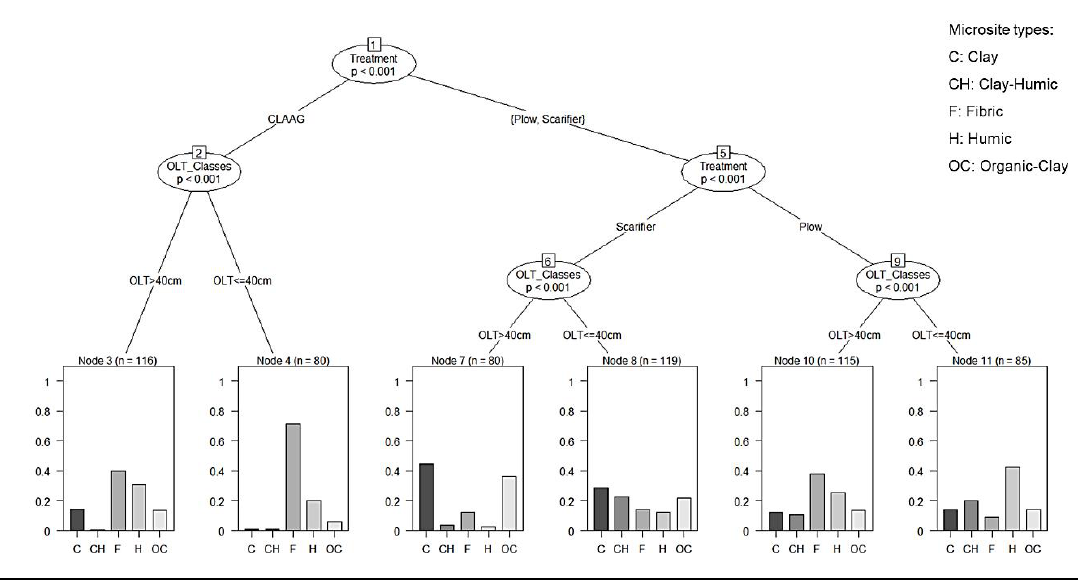
Figure 3. Percent microsites exposed by treatment and by post-CLAAG organic layer thickness (low to moderate OLT ≤ 40 cm and high OLT > 40 cm).